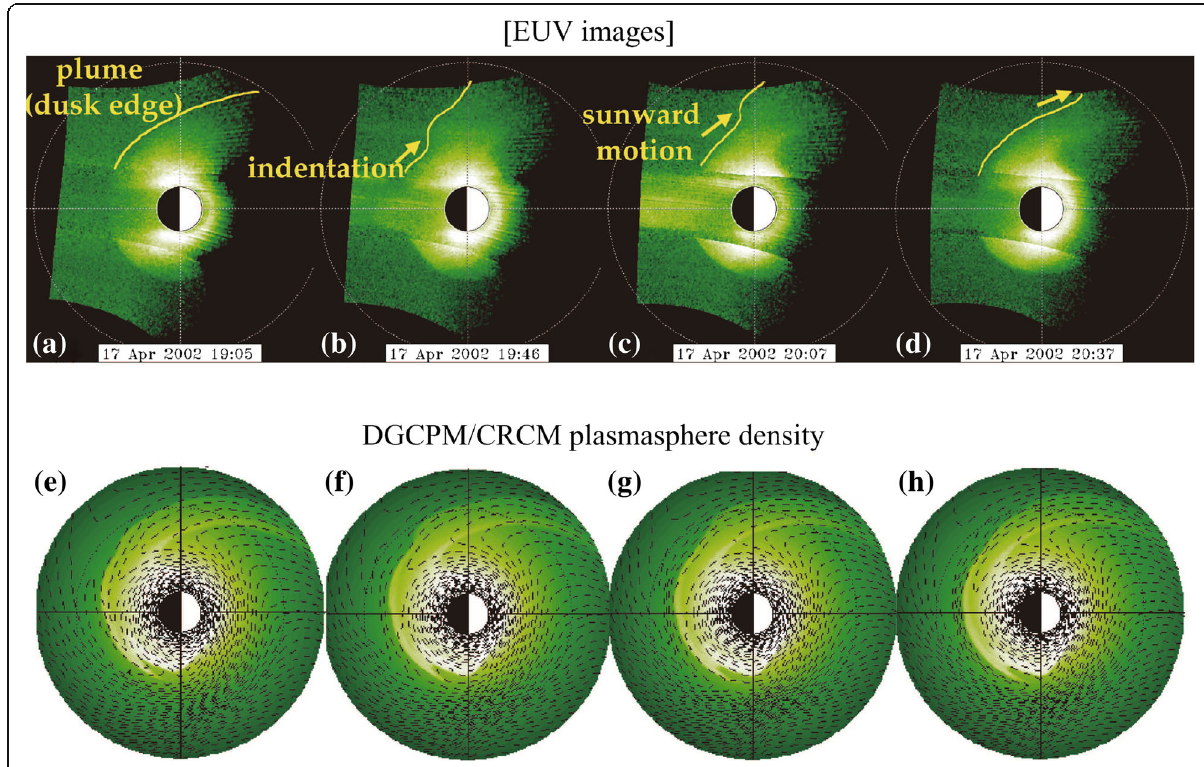
Fig. 11 Influence of ring current-ionosphere coupling on the plasmasphere. An indentation of the plasmapause propagates sunward. Top panels show the observation by the IMAGE satellite. The bottom ones show the cold electron density obtained by the simulation. (Fok et al. 2005)